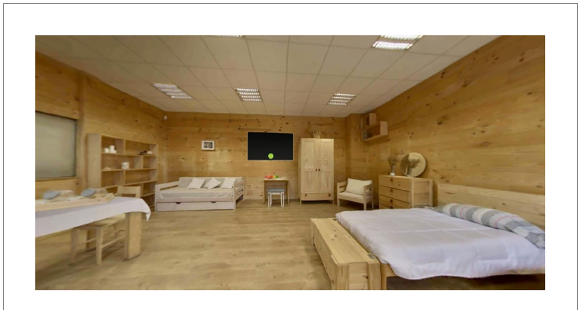
FIGURE 2 Screenshot of Nesplora Suite test. Reproduced with permission from Giunti-Nesplora